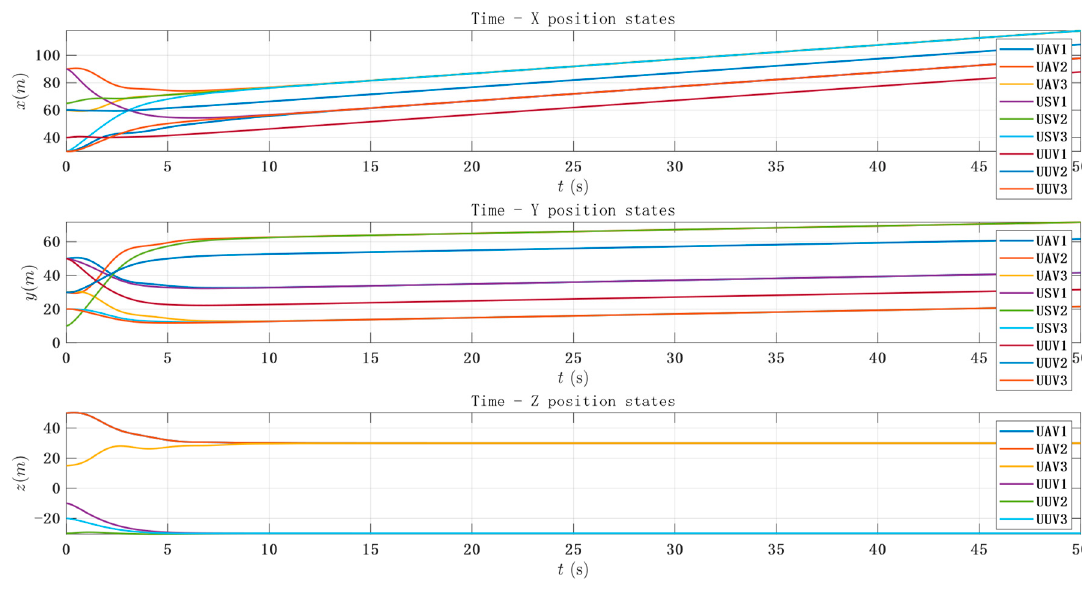
Figure 12. Dynamic formation state with cooperative control and optimal control.